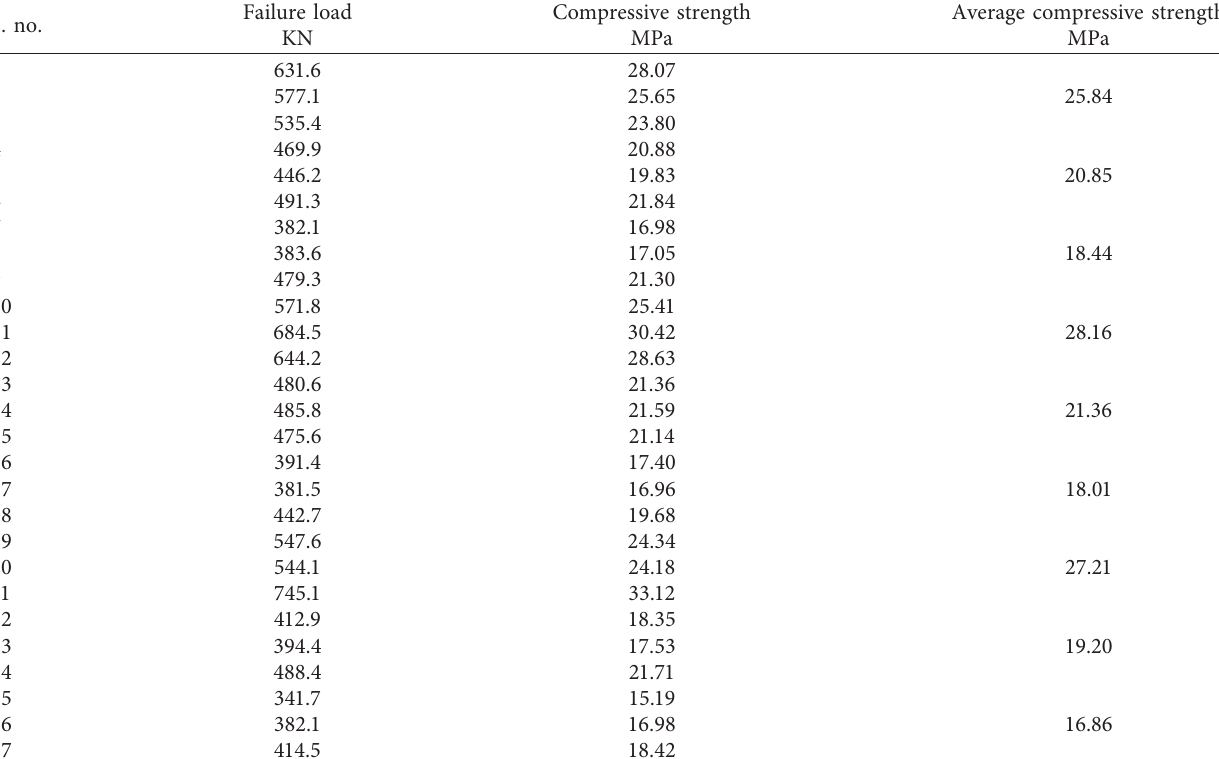
Table 6: Permeable concrete specimen compressive strength test